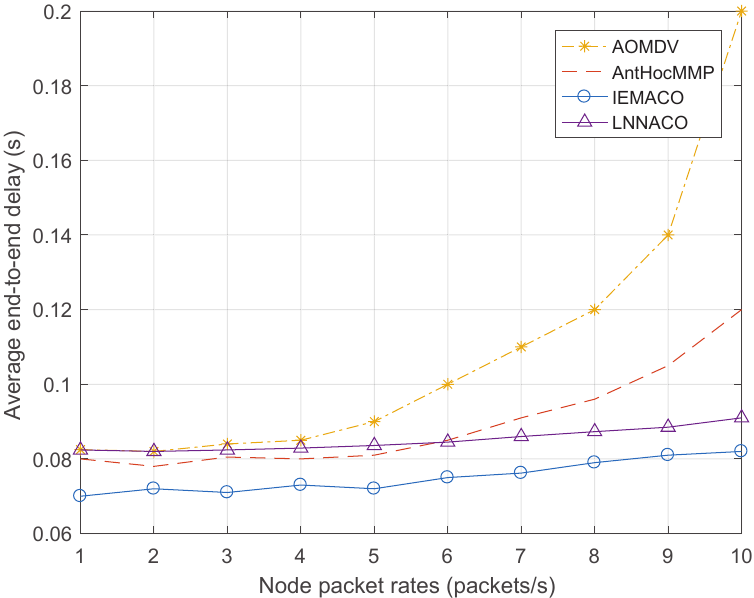
Figure 8. Average end-to-end delay versus node packet